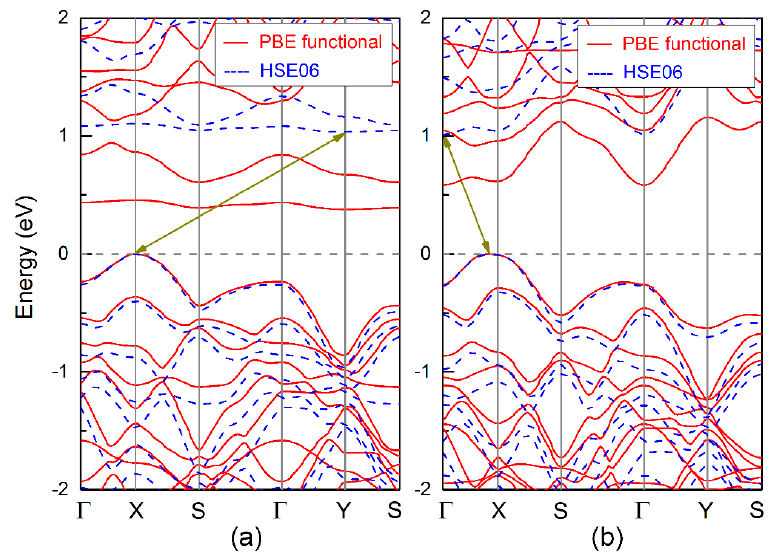
Figure 6. Electronic band structure for the defective boron-phosphide monolayers: ( a ) D_v and ( b ) SW defects.